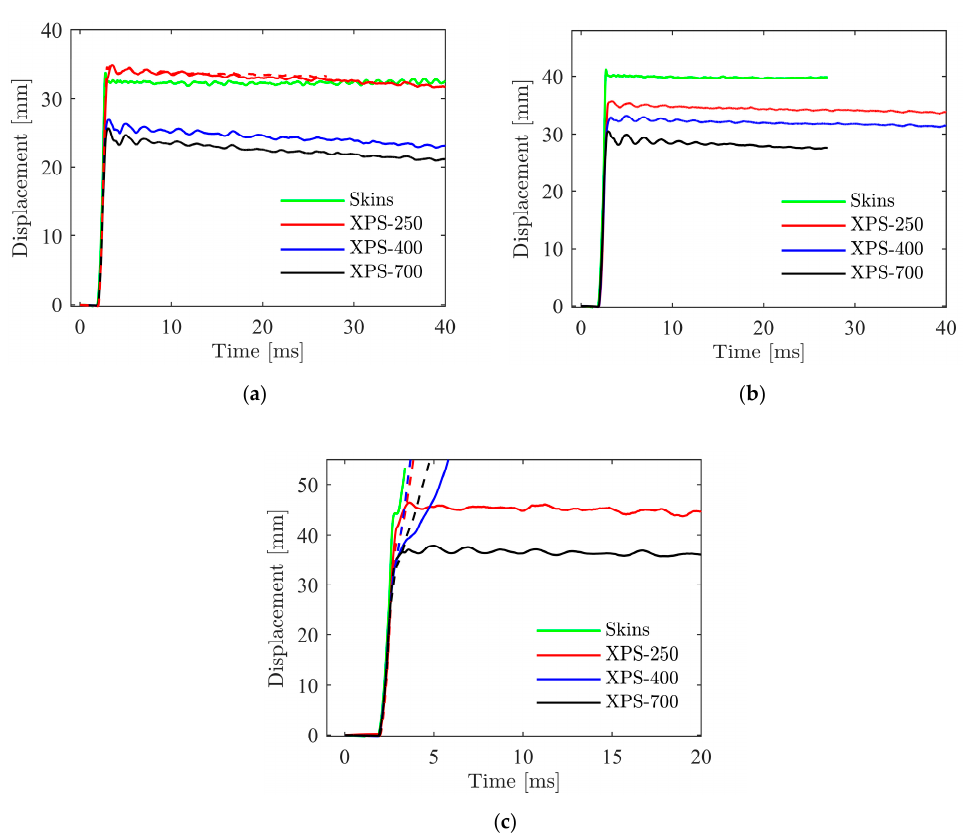
Figure 11. Mid-point displacement of the aluminium skins only and the sandwich panels at (a) 10 bar firing pressure, (b) 12 bar firing pressure and (c) 15 bar firing pressure. Solid and dashed lines are used for series 1 and 2, respectively.